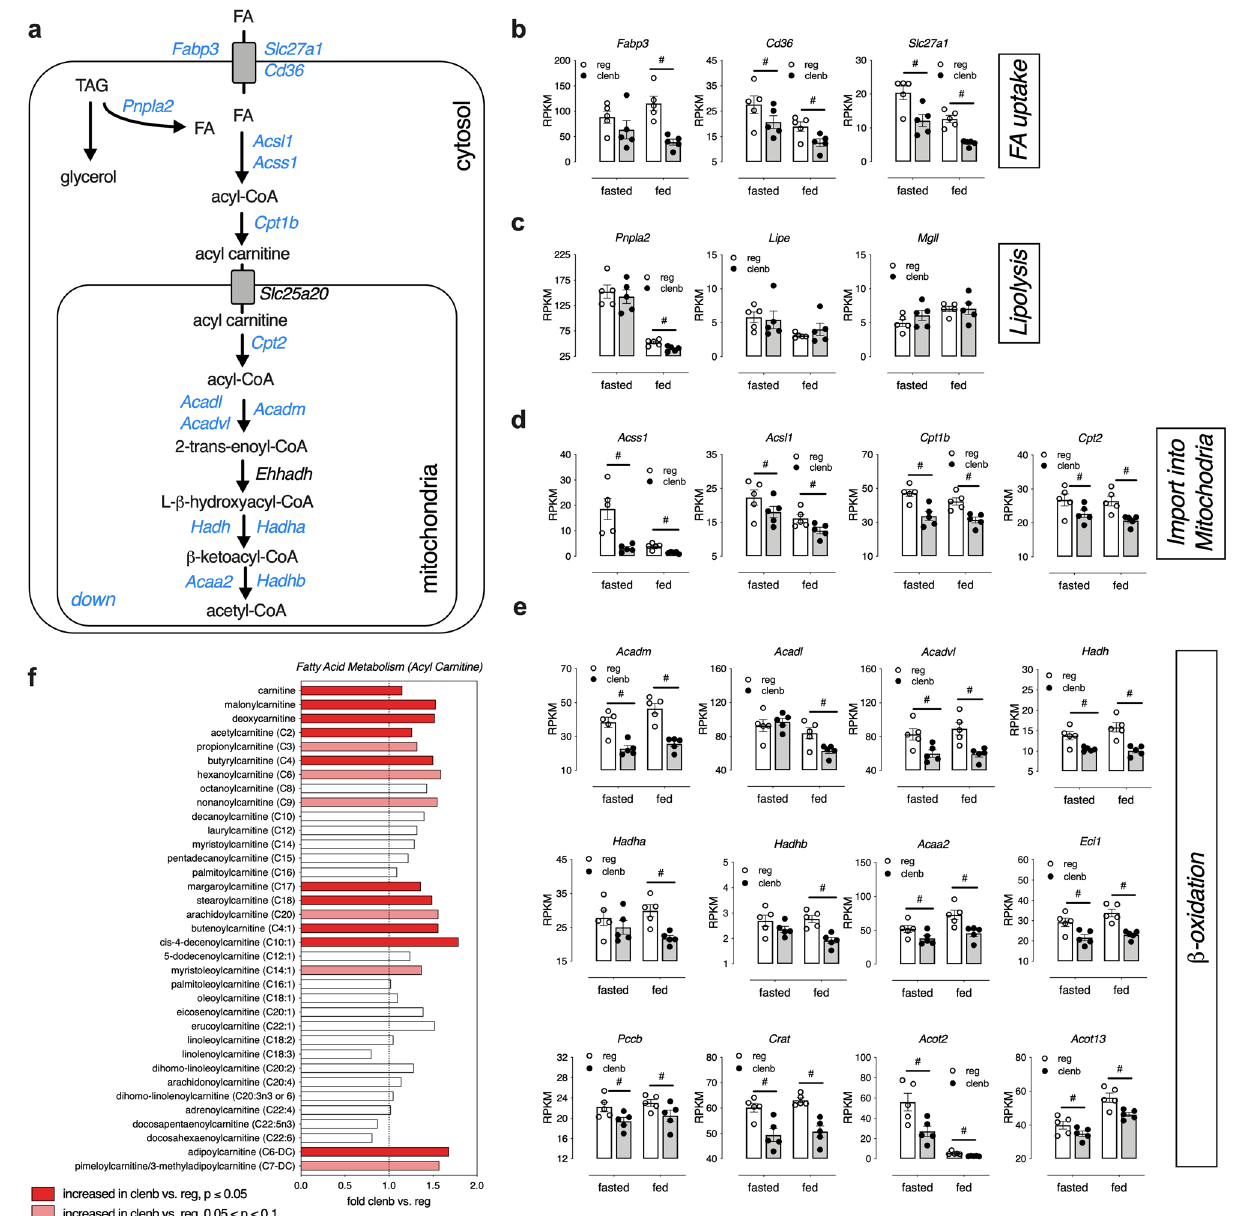
Fig. 4 Chronic clenbuterol treatment decreases fatty acid oxidation in SKM in vivo. Prior to metabolomics and gene expression studies, lean WT mice consumed drinking water containing clenbuterol (30 mg/l; clenb. H 2 O) or regular drinking water (reg. H 2 O) for 5 days. All studies were carried out with male mice that were ~12 weeks old. a Graphic representation of differentially expressed genes within the fatty acid oxidation pathway in SKM (quadriceps muscle) of clenb. H 2 O vs. reg. H 2 O mice ( n = 5/group). b – e Changes in the levels of SKM transcripts involved in fatty acid (FA) uptake ( b ), lipolysis ( c ), import of FAs into mitochondria ( d ), and FA β -oxidation ( e ). SKM gene expression levels (RPKM) were determined via RNA-Seq in fasted (15 h) and freely fed WT mice by using the Genomatix Genome Analyzer platform. Data are presented as means ± SEM. # Signi fi cantly regulated (two-tailed Wald test (DESeq2)) ( n = 5/group, adjusted p -value < 0.05). f Fold changes (clenb. vs. reg. H 2 O) of acylcarnitine levels in SKM of fasted (15 h) WT mice, determined by high-throughput metabolomics ( n = 7/group). The red bars indicate signi fi cant clenbuterol effects (ANOVA contrast). RPKM, reads per kilobase of transcript per million of mapped reads. Source data are provided as a Source data fi